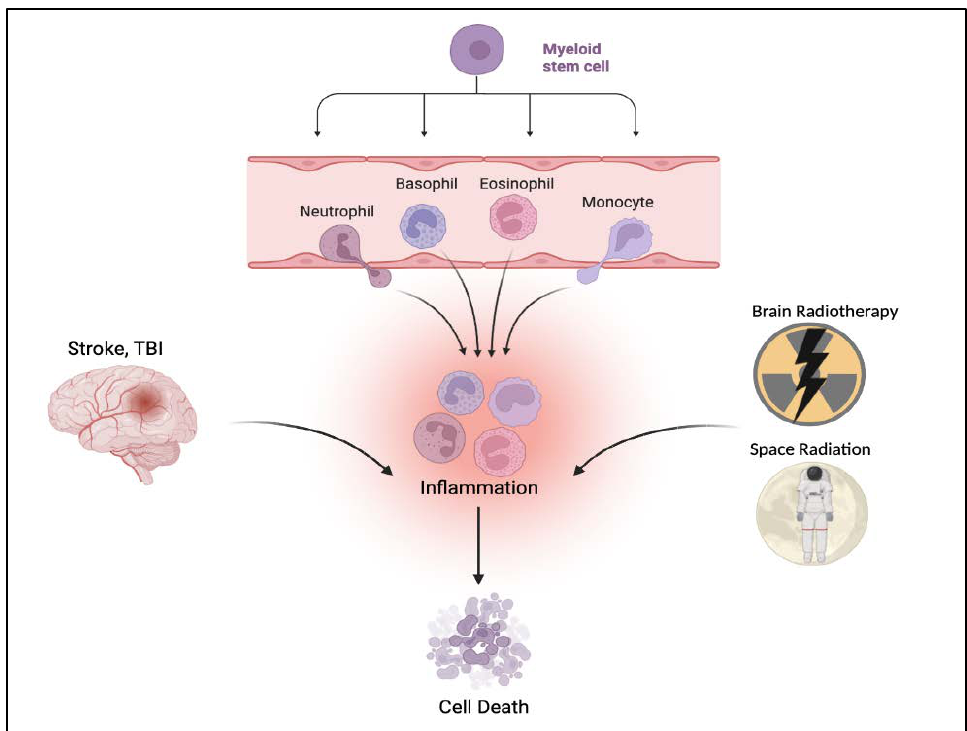
Figure 1. Inflammatory cells, such as neutrophils, dendritic cells and monocytes, arising from myeloid progenitor cells, infiltrate the brain altogether triggering inflammation then cell death in response to neural injury caused by stroke, TBI, brain radiotherapy and space radiation. Figure constructed via Biorender.com.